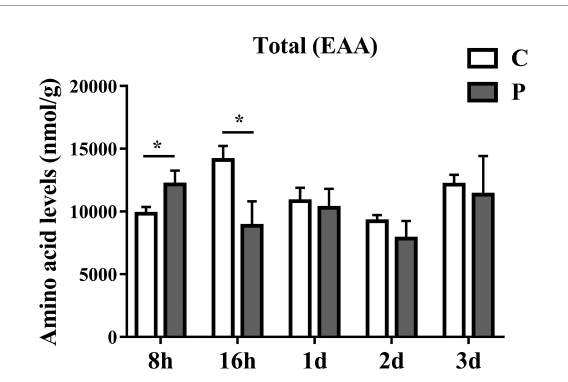
FIGURE2 Parasitism causes changes in the content of total EAA (Essential Amino Acids) in cotton aphid. Statistical significance (Student’s t -test): * P < 0.05; ** P < 0.01; *** P < 0.001.